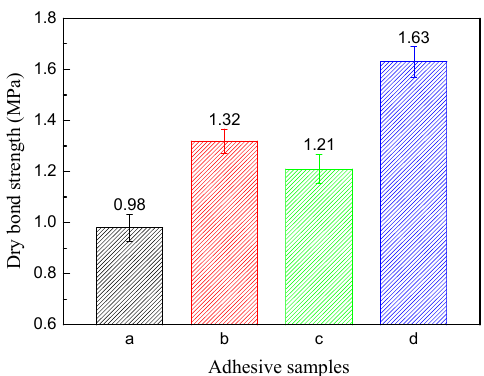
Figure 3. The dry bond strength of the plywood with the different adhesives: ( a ) SF adhesive; ( b ) SF/LB adhesive; ( c ) SF/PAE adhesive; and ( d ) SF/LB/PAE adhesive.